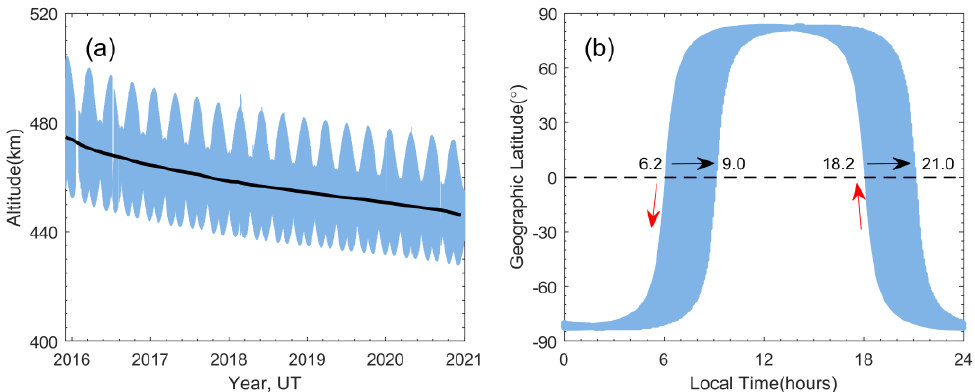
Figure 1. Changes in the spatial position of the APOD satellite from December 2015 to December 2022: ( a ) altitude, with the solid black line indicating the monthly mean altitude; ( b ) latitude and local time (LT) relationship, with the red arrow indicating the direction of the satellite’s motion on a single orbit, and the black arrow indicating the direction of the satellite’s LT